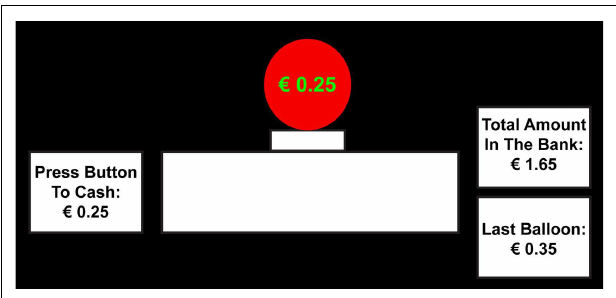
FIGURE 1 | BalloonAnalog RiskTask (BART). Participants inflated a balloon until they decided to cash-out or until it popped and the accrued earnings on that trial were lost. Participants completed both high and low risk blocks of the